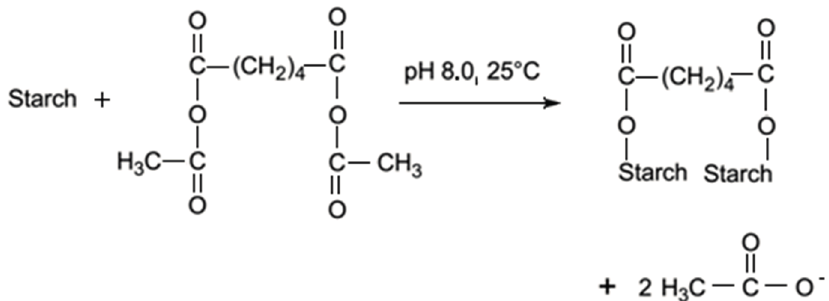
Figure 3. Cross - linking of starch with adipate